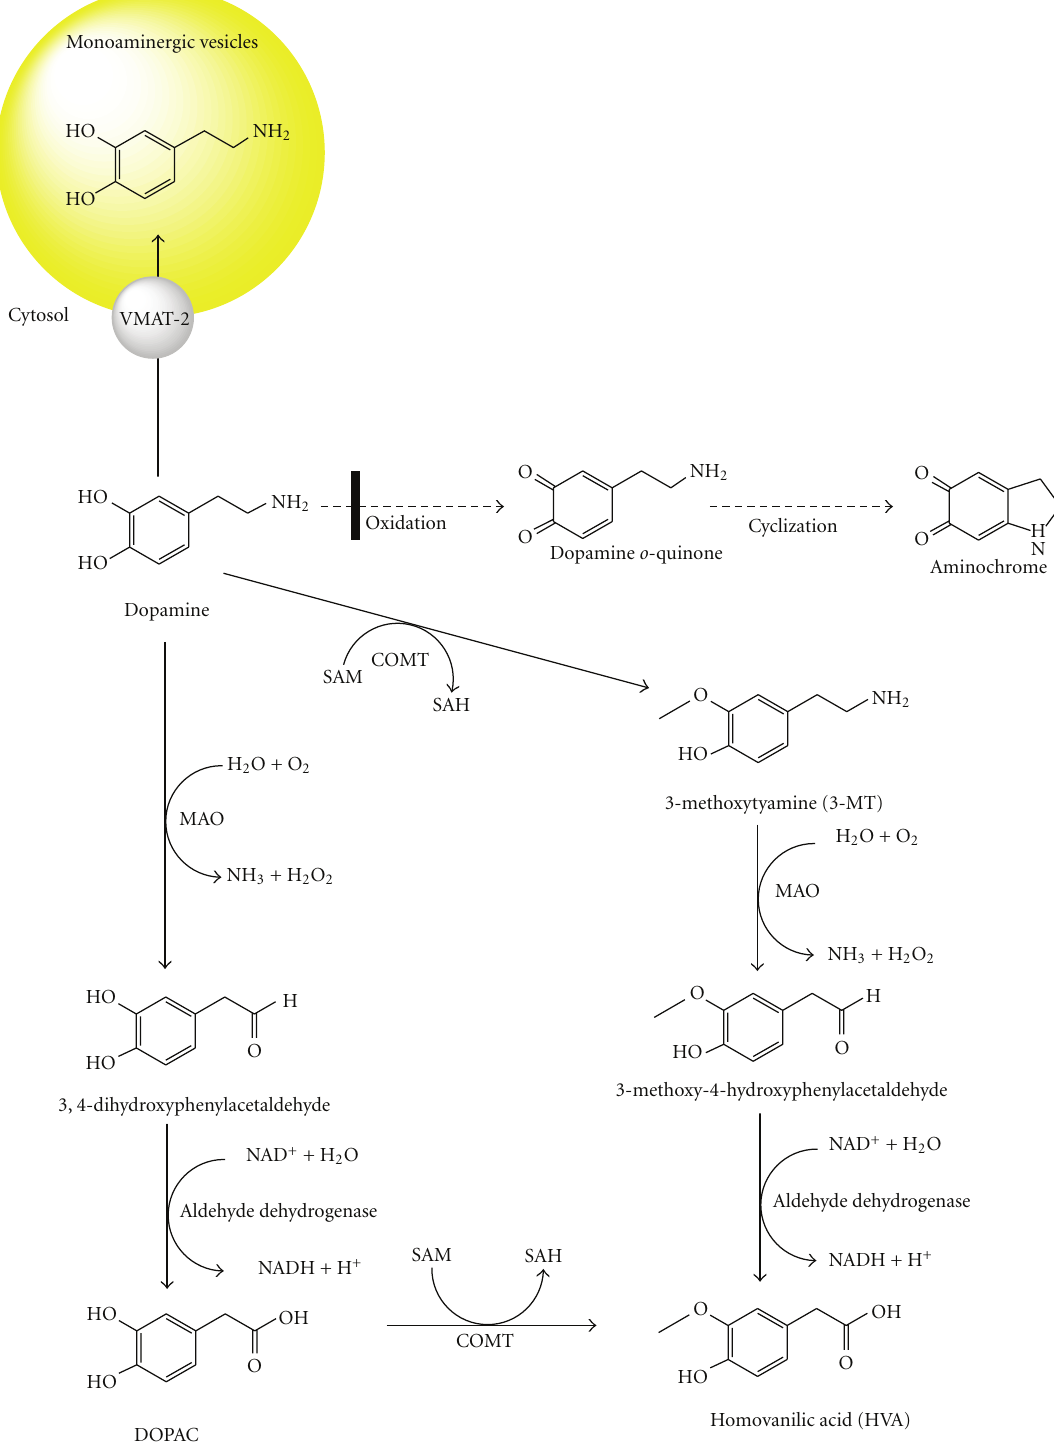
Figure 2: Dopamine degradation catalyzed by MAO and COMT. Dopamine oxidation to aminochrome is prevented by dopamine degradation mediated by both MAO and COMT. MAO catalyzes the oxidative deamination of dopamine amino group to 3,4- dihydroxyphenylacetaldehyde, that is converted to 3,4-dihydroxyphenylacetic acid (DOPAC) catalyzed by aldehyde dehydrogenase. COMT catalyzes the methylation of dopamine to 3-methoxytyramine that is substrate for MAO that catalyzes the formation of 3-metoxy-4- hydroxyphenylacetaldehyde. Homovanillic acid is formed when MAO uses 3-metoxy-4-hydroxyphenylacetaldehyde as substrate or when DOPAC is metabolized by